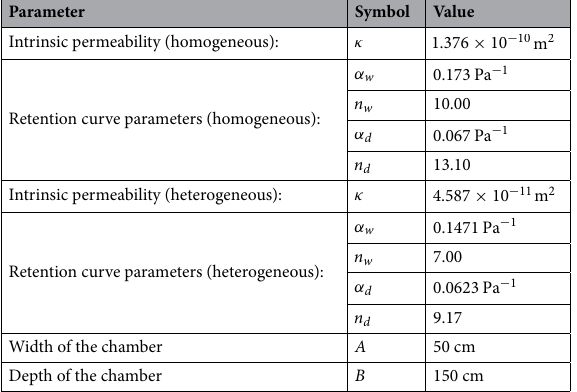
Table 2. Parameters used for reproducing the flow across layers of porous media with different characteristics. Parameters not included in this table were the same as in Table 1.